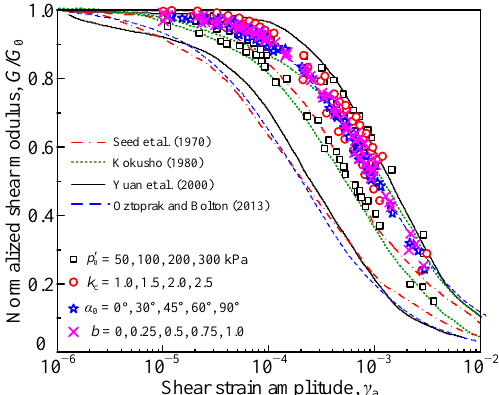
Figure 11. Shear modulus reduction curves of saturated coral sand under various consolidation conditions.